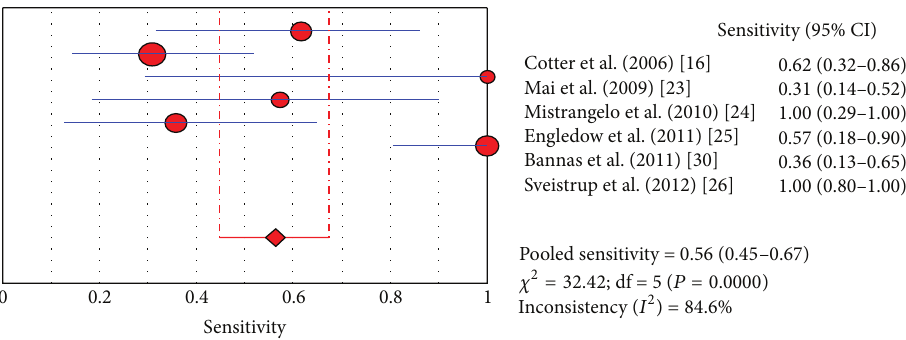
Figure 2: Plot of individual studies and pooled sensitivity of FDG PET/CT in detecting locoregional node involvement in patients with ACC, including 95% confidence interval. The size of the circles indicates the weight of each study.